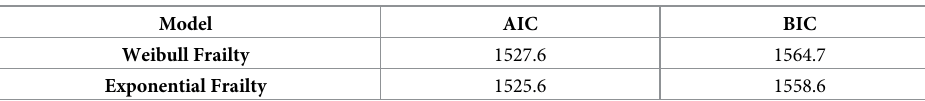
Table 4. The GOF values of regression